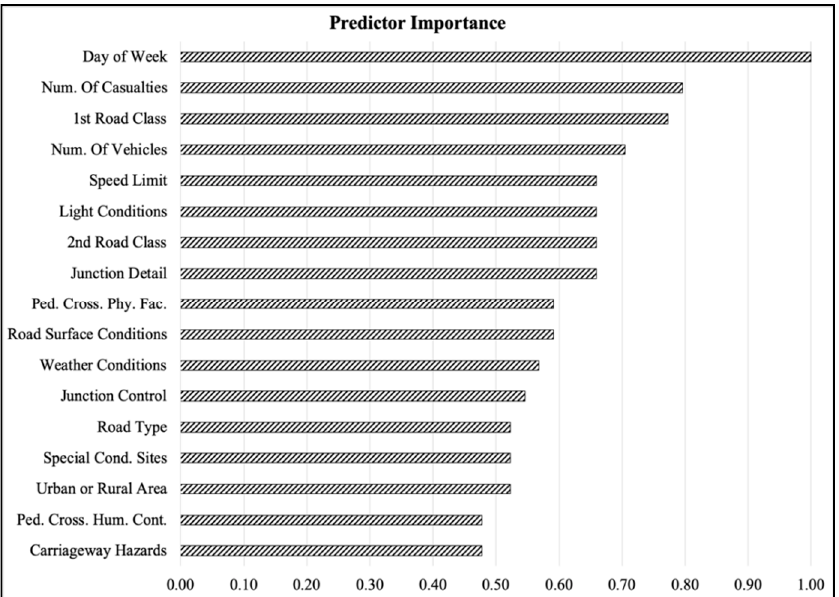
Figure 6. Attribute importance based on average impurity decrease.